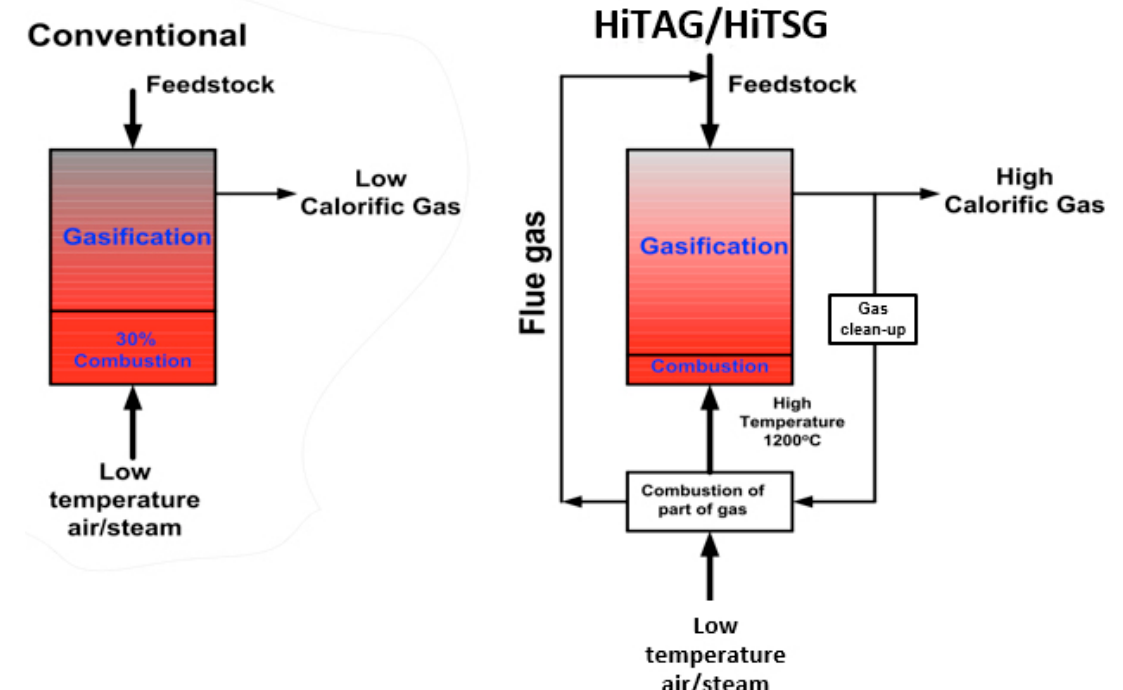
Figure 4. Comparison between conventional and HiTAG / HiTSG gasification. In the conventional system, the process involves lower temperatures (approx. 600–700 ◦ C) and produces a low-calorific gas polluted with tars, ash, or even dioxin and furans. On the other hand, in the HiTAG / HiTSG system, ceramic regenerator allows obtaining high temperatures of the feed gas (flue gas) which produces high calorific and cleaner